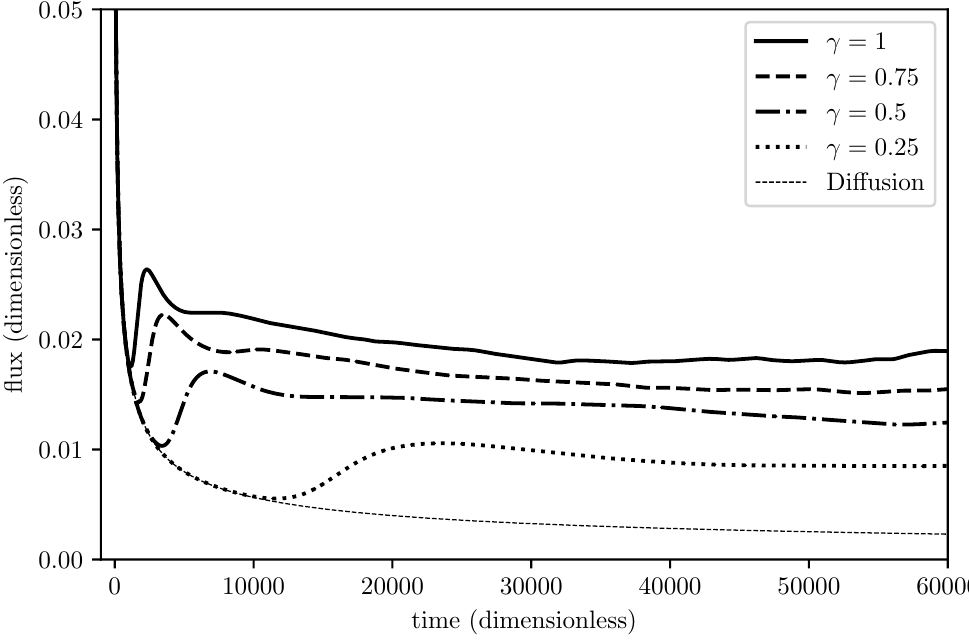
Figure 6. Dimensionless flux across the top boundary for anisotropic homogeneous porous media in three dimensions. The dashed horizontal lines show the estimated steady flux 0.018